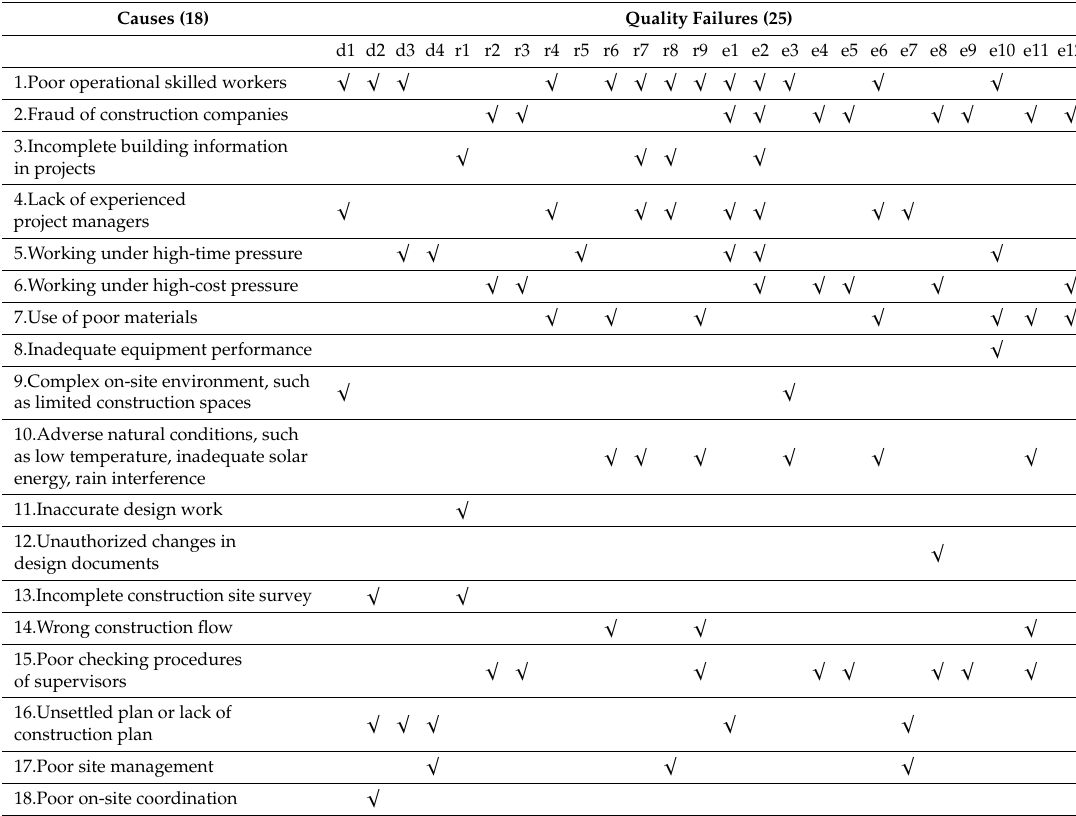
Table 6. The quality failures contributed by the causes. Causes (18) Quality Failures